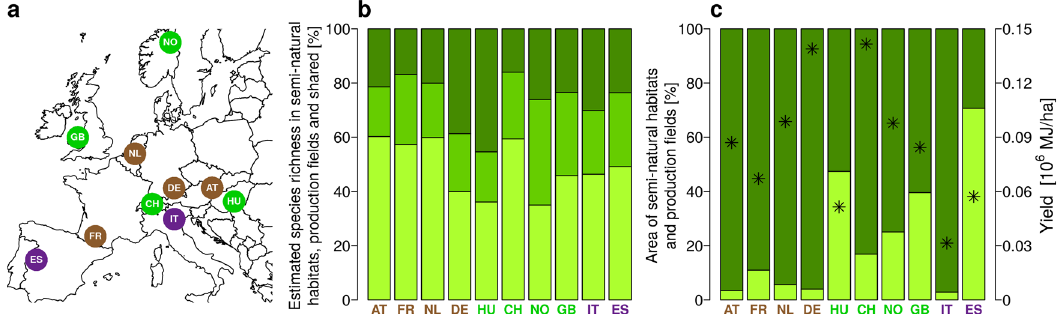
Fig. 1 Importance of semi-natural habitats for biodiversity in ten European farmland regions. a Location of the study regions with dominant type of agricultural land use (brown: arable crops, mixed systems and horticulture, bright green: grassland, violet: permanent crops). b Proportions of summed vascular plant, earthworm, spider and bee species unique to semi-natural habitats (light green bars), shared by the semi-natural habitats and production fi elds (medium green bars) and unique to production fi elds (dark green bars) per region (per taxa separately in Supplementary Fig. 1). c Percentage of farm area occupied by semi-natural habitats (light green bars) and production fi elds (dark green bars) per region, and average yield (stars) over fi elds of sampled farms in the ten study